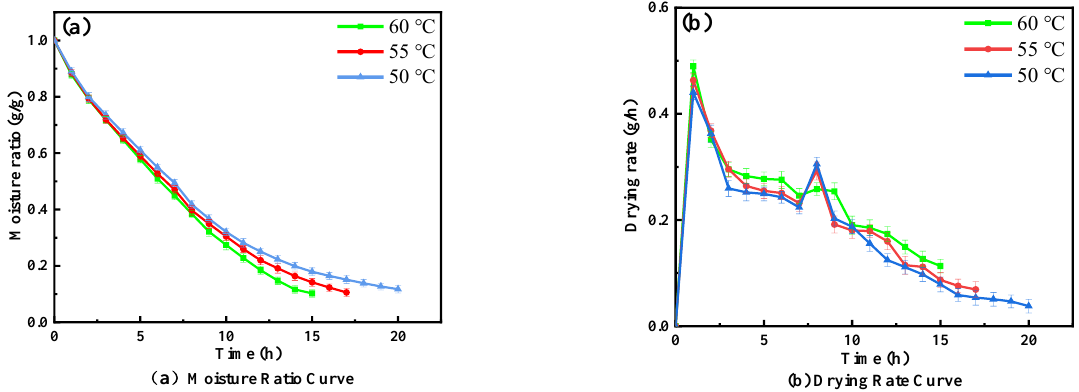
Figure 4. Effects of different temperatures on drying characteristics.